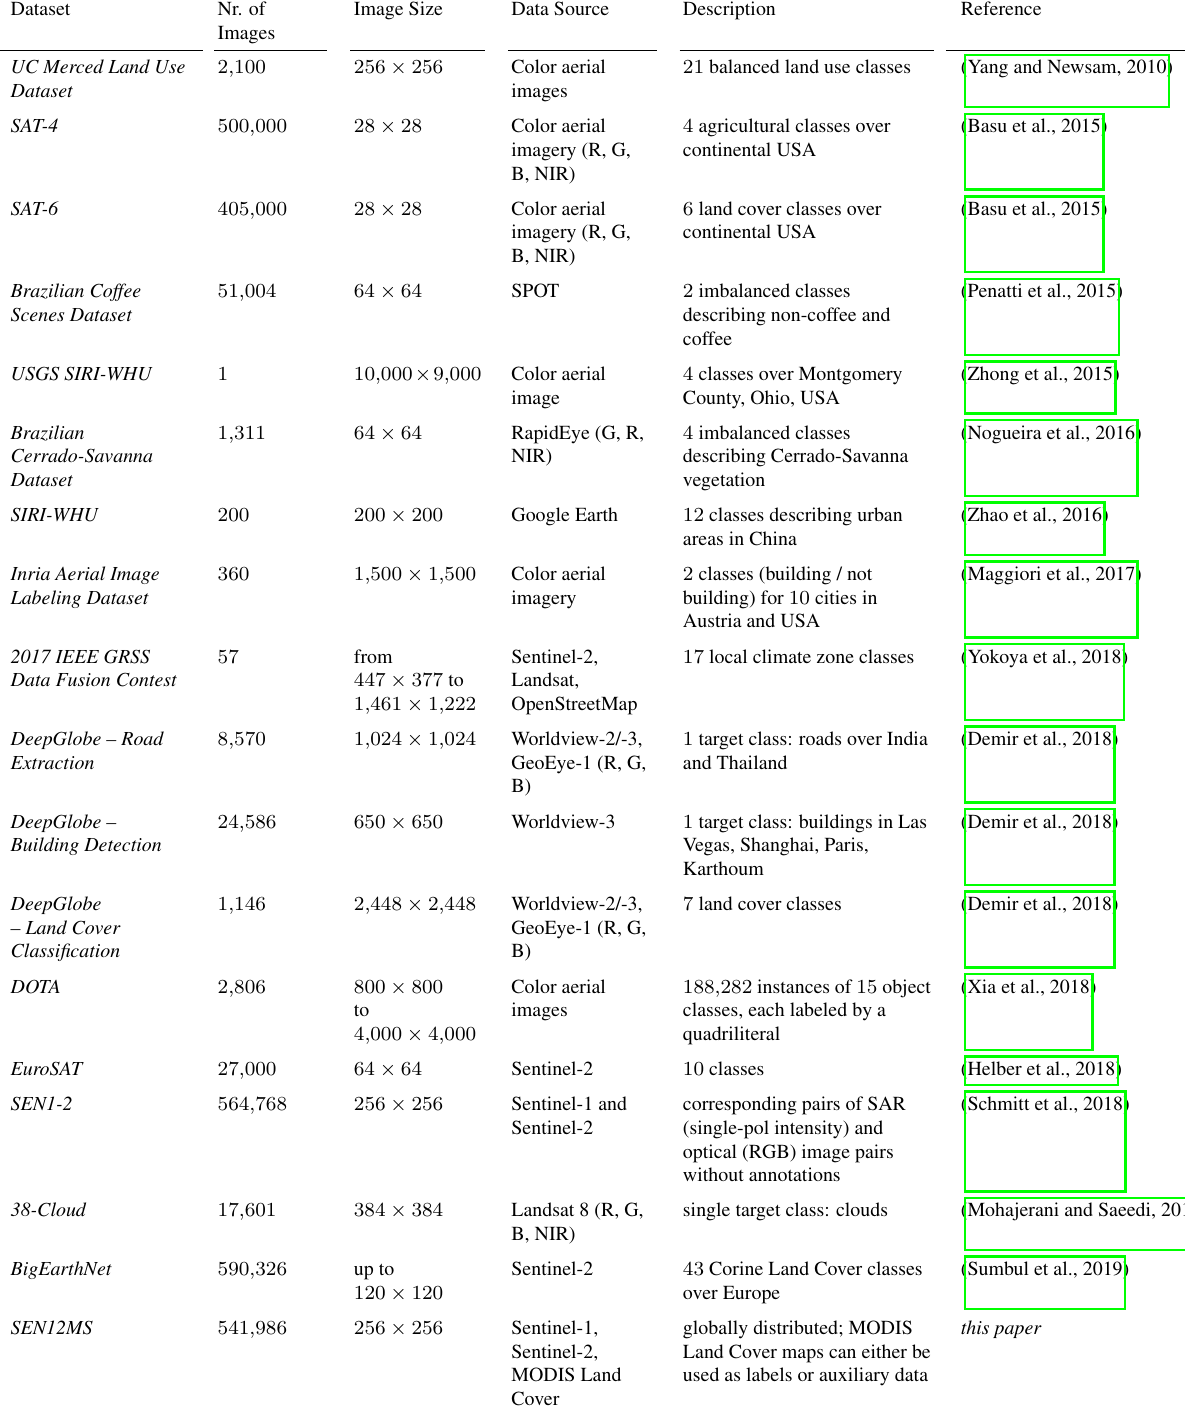
Table 1. Non-exhaustive list of curated datasets for deep learning in remote